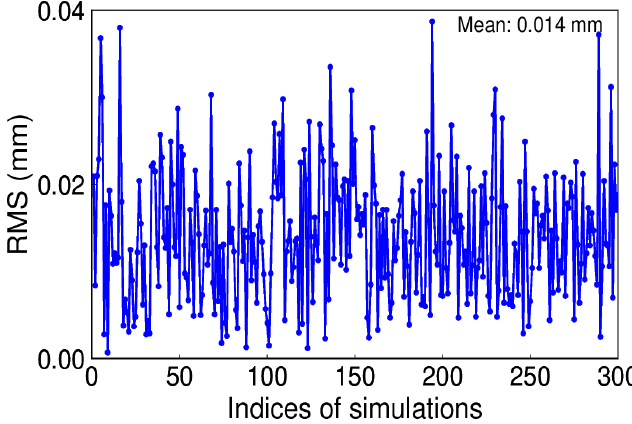
Figure 8. Root mean square (RMS) of extracted and simulated signal with white noise.